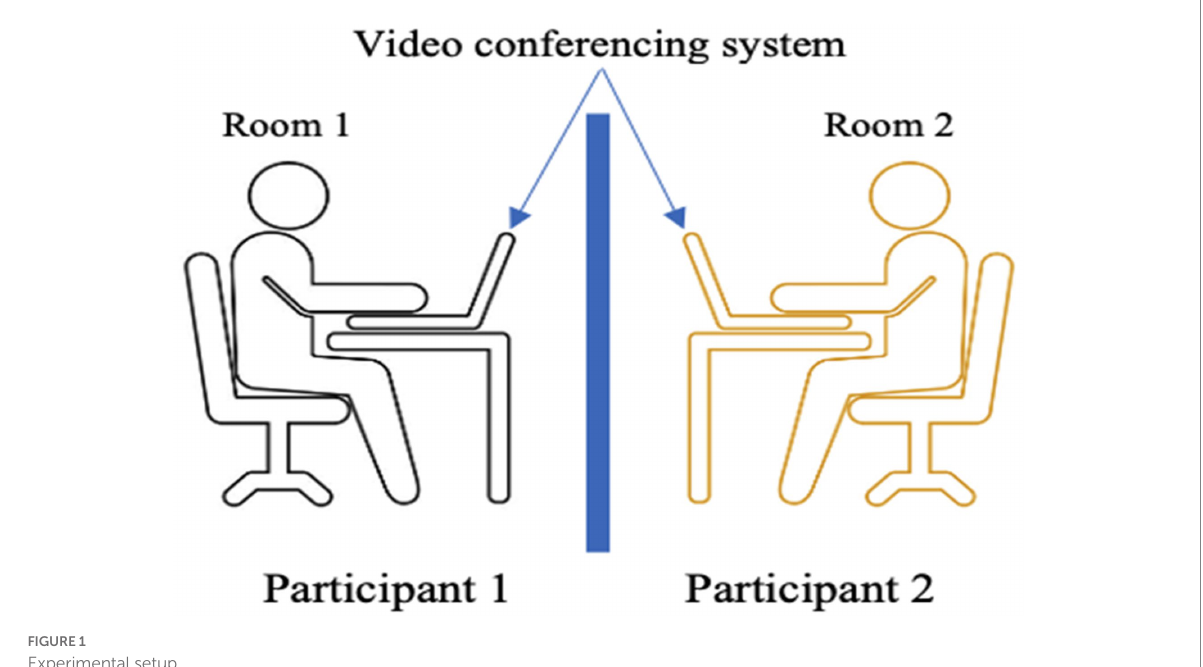
FIGURE 1 Experimental